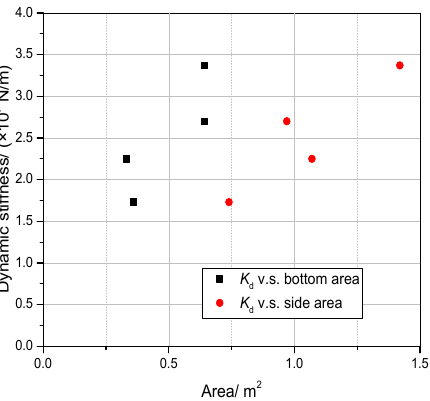
Figure 8. Dynamic stiffness value variations in the spread and caisson foundations with side and bottom areas.